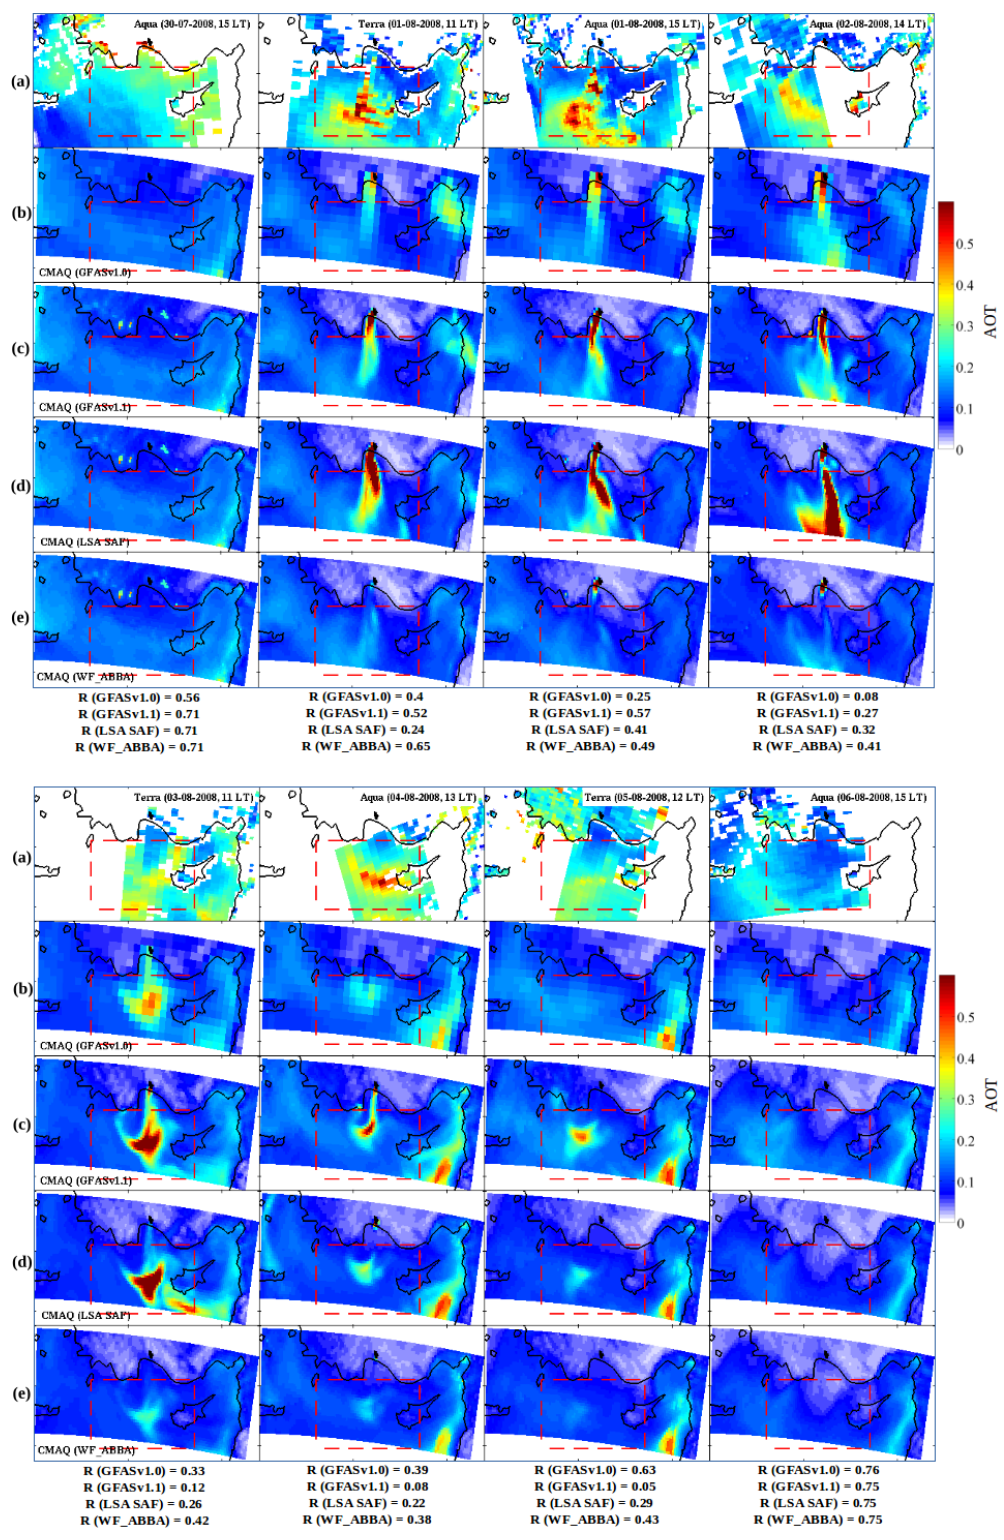
Figure 9. (a) Instantaneous MODIS AOT retrievals over the eastern Mediterranean basin from 30 July to 6 August 2008. Concurred CMAQ- simulated AOT using GFAS1.0- (b) , GFAS1.1- (c) , LSA SAF- (d) and WF_ABBA-based (e) fire emission inventories. Pearson’s R coeffi- cients between MODIS observed and CMAQ-simulated AOT are given